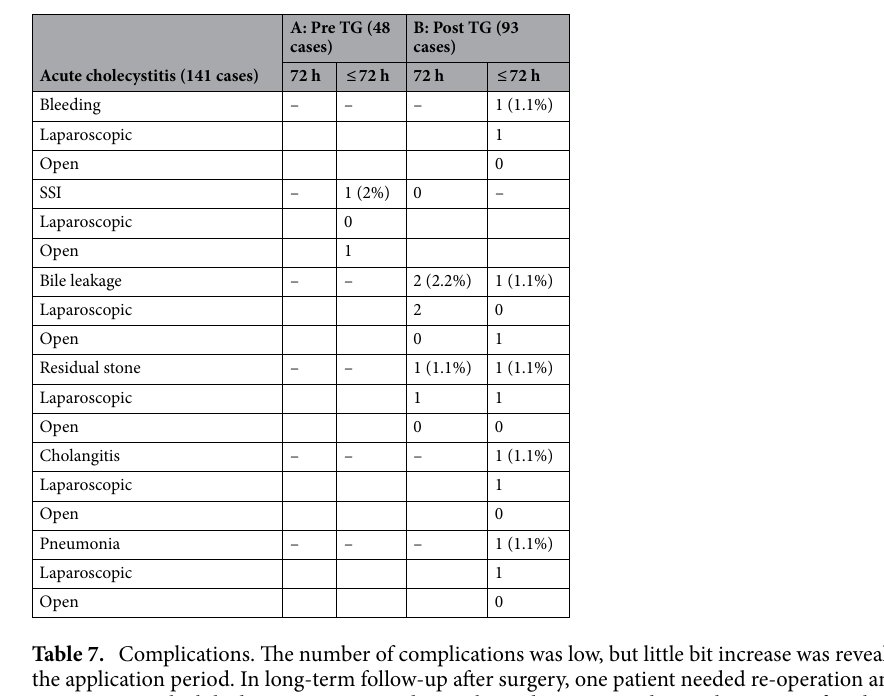
Table 7. Complications. The number of complications was low, but little bit increase was revealed during the application period. In long-term follow-up after surgery, one patient needed re-operation and biliary reconstruction by bile duct stones centered on a clip and Mirizzi syndrome three years after the initial operation. In addition, this case was one of 4 cases of partial cholecystectomy.